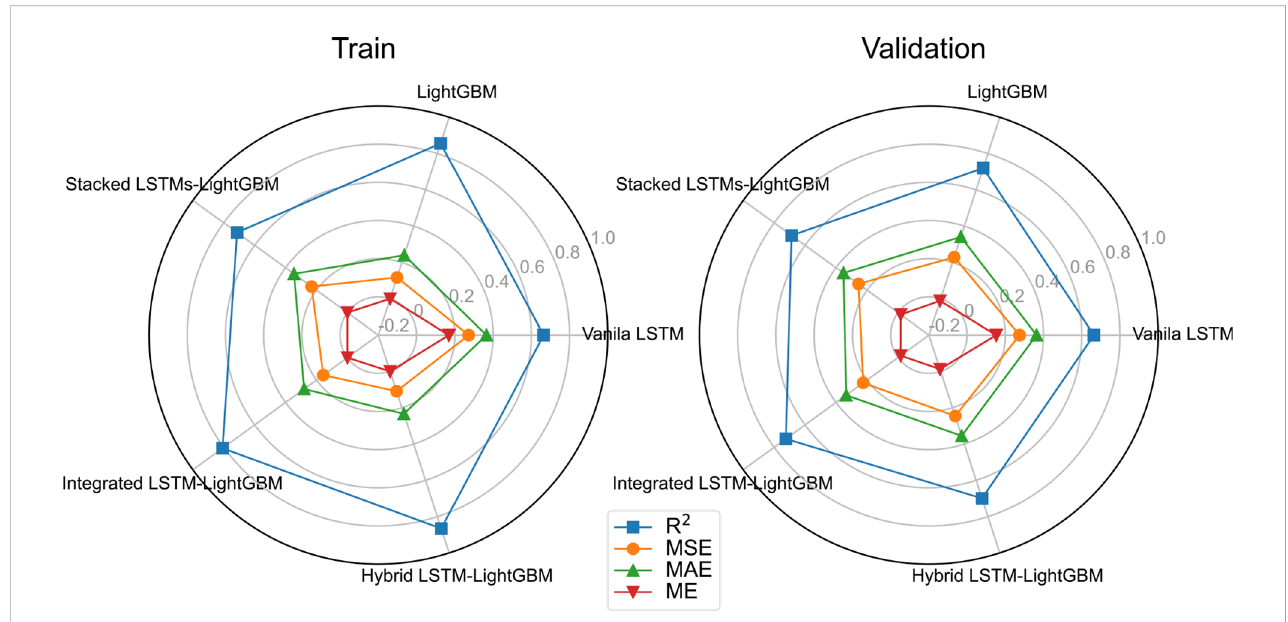
FIGURE 5 Performance Evaluation for the fi ve algorithms on the validation and test subsets.